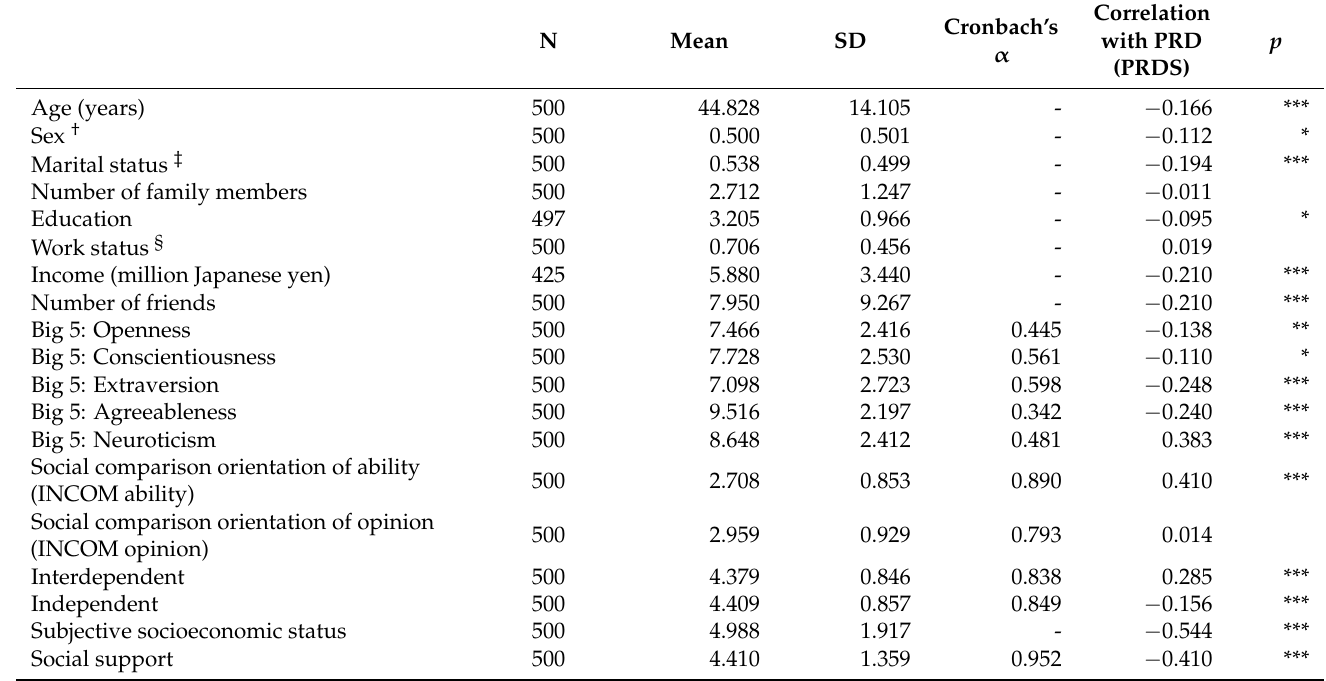
Table 2. Correlation between PRD and demographic factors and variables for the assessment of external criterion-referenced validity of the